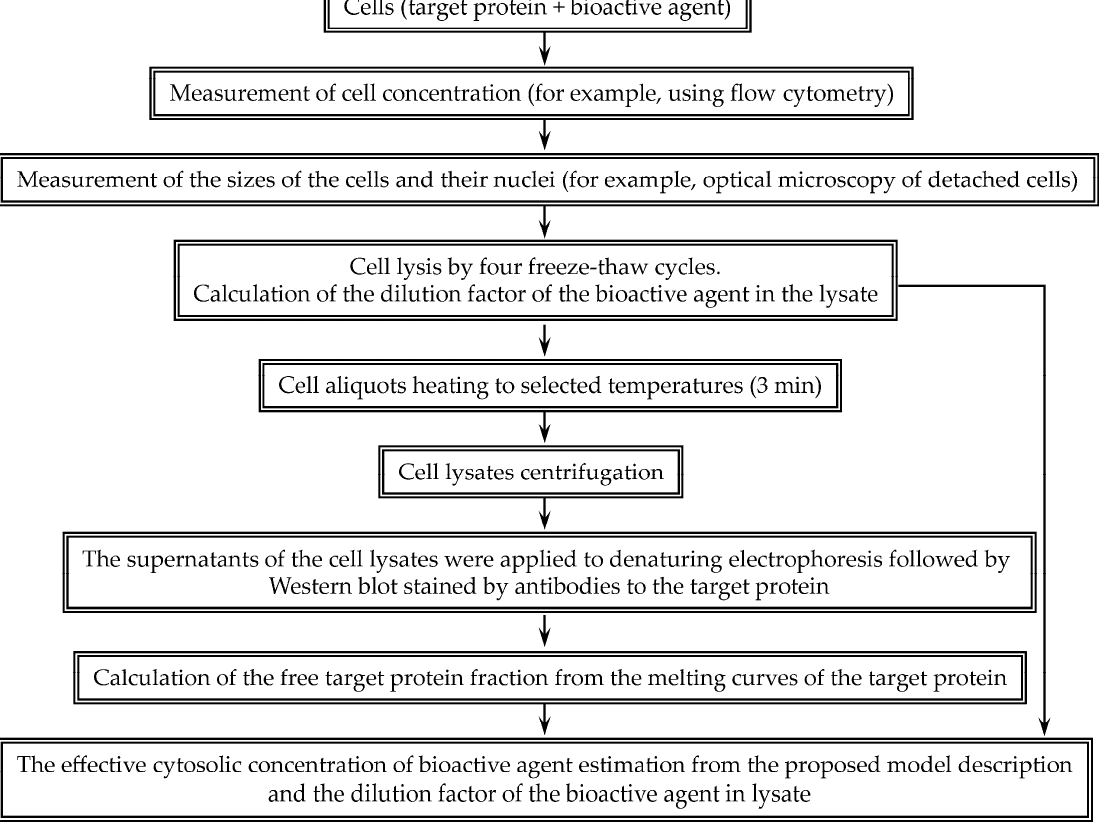
Figure 1. Scheme of our approach to evaluate the effective cytosolic concentration of bioactive agents interacting with a selected intracellular target protein.